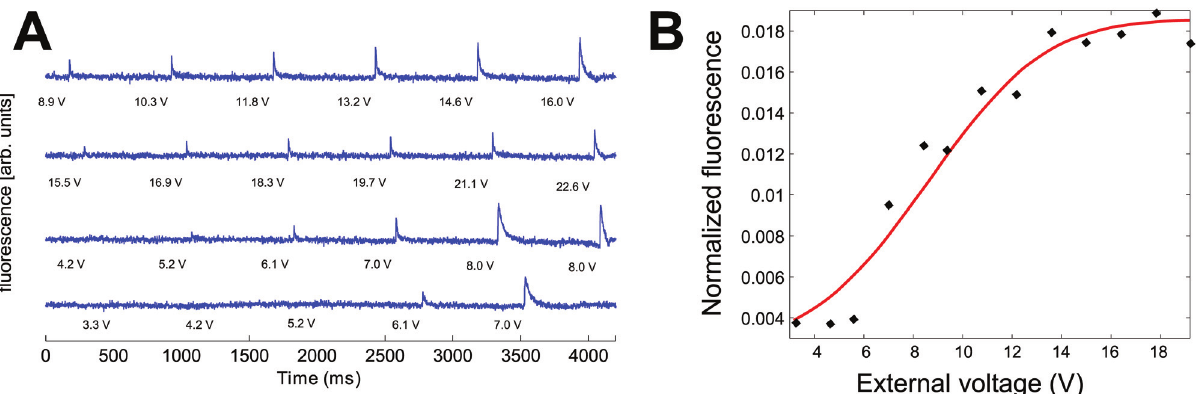
Fig 2. Measuring population threshold from fluorescence intensity as a function of the field strength for a given duration. (A) Fluorescence intensity measured using calcium imaging, from about 100 neurons in the 1D culture that are within the field of view of the microscope. CNQX, APV and bicuculline were used to completely disconnect the network. External stimulation was given at times marked by the vertical grey lines. The four blue curves show typical fluorescence responses of the network, with excitation seen as a sharp increase in fluorescence intensity. The number adjacent to the grey line represents the amplitude of the stimulating signal (in volts). (B) At a fixed pulse duration, the intensity of the normalized fluorescence vs. voltage used for stimulation is a cumulative Gaussian distribution. The mean minimal amplitude needed for stimulation ( “ Strength ” ) was obtained by fitting each experimentally measured fluorescence intensity as a function of the electric field amplitude to a cumulative Gaussian distribution (the Error function) and extracting the expectation value of the Gaussian, The half maximum of this curve is thus taken as the threshold for excitation of the neuronal population.